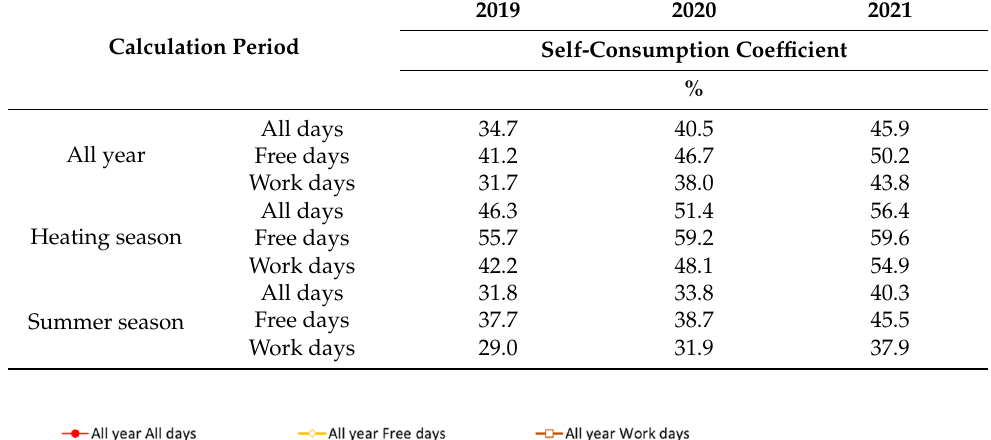
Table 8. The self-consumption over year 2019, 2020 and 2021.